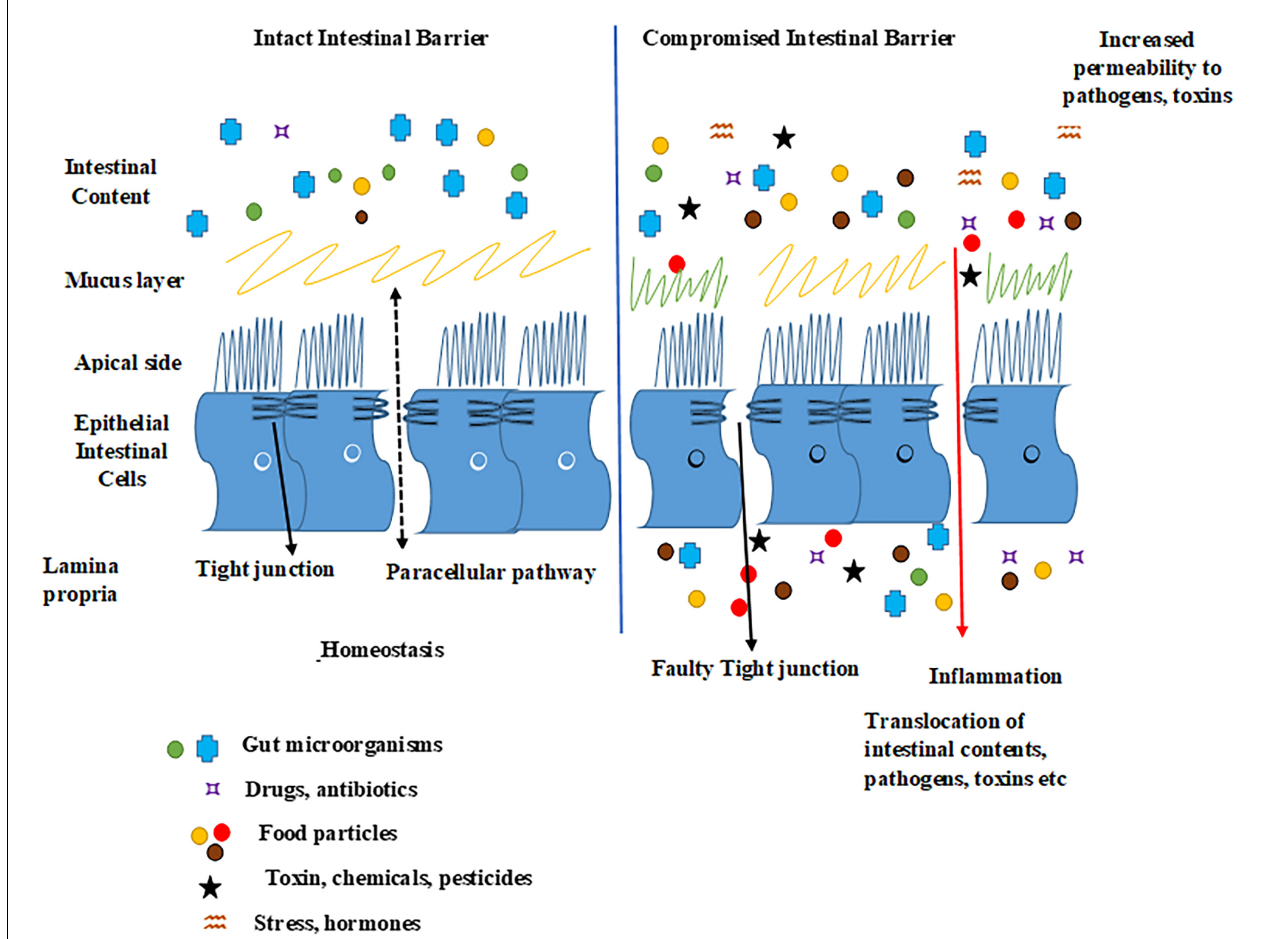
FIGURE 4 | Schematic presentation of healthy and leaky gut. Epithelial tight junctions are intact in a healthy gut and selectively lets some molecules in and out of the intestinal epithelium by functioning as a seal between the neighboring gut cells, hence maintaining homeostasis. Factors such as proinflammatory mediators, microbial gut imbalance, infections, some foods, exposure to chemicals, toxins, or stress may disrupt epithelial tight junctions and increase the intestinal permeability, as well as possibly damage the intestinal barrier by forming tissue lesions and punctures that could lead to a leaky intestinal epithelium. This whole sequence of events may lead to the translocation of undesired luminal gut content (microorganisms, toxins, undigested food particles) into the host tissues activating an immunological